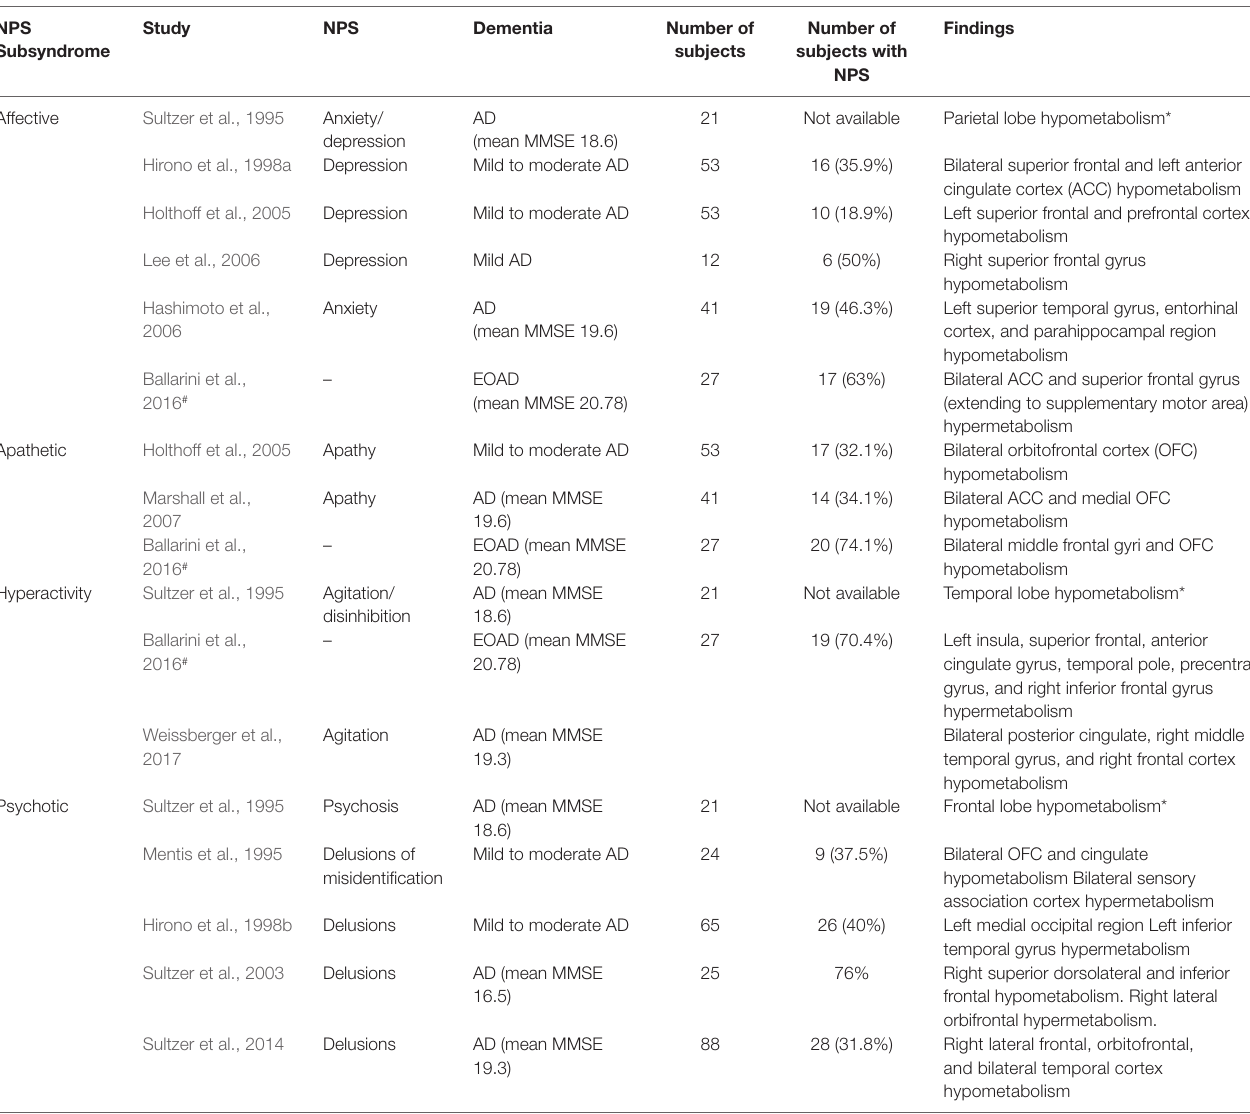
TABLE 1 | Summary of metabolic dysfunction in AD dementia subjects with NPS by subsyndromes.